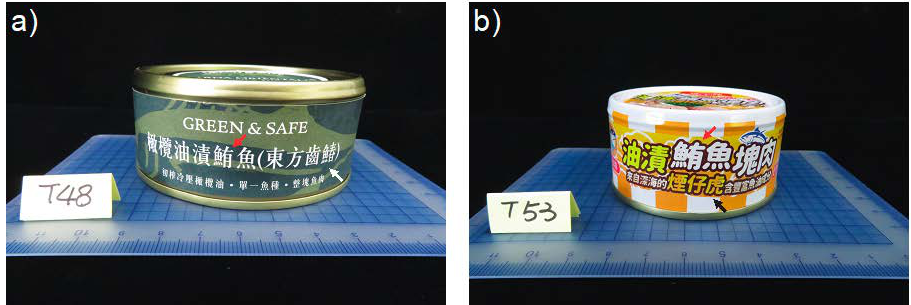
Figure 1. Taiwanese canned tuna products displaying inconsistent labeling. “ 鮪 ” (red arrows) in the Chinese labels declares both of these canned tuna products as legally being made from Thunnus fishes or skipjack tuna ( Katsuwonus pelamis ) (in Chinese: 正鰹 ). ( a ) Oriental bonito ( Sarda orientalis ) (in Chinese: 東方齒鰆 ) (white arrow) in the label indicates the product contains that species. ( b ) The Chinese vernacular name 煙仔虎 (black arrow) may represent both oriental bonito and skipjack tuna.